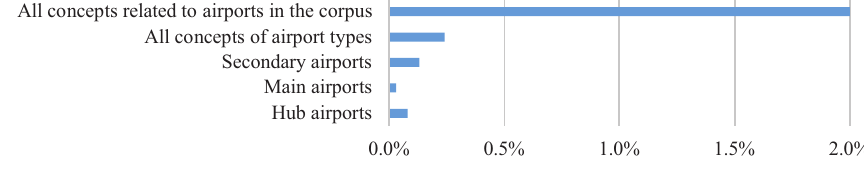
Figure 1. Summary of distribution of airport types in the corpus (created by the